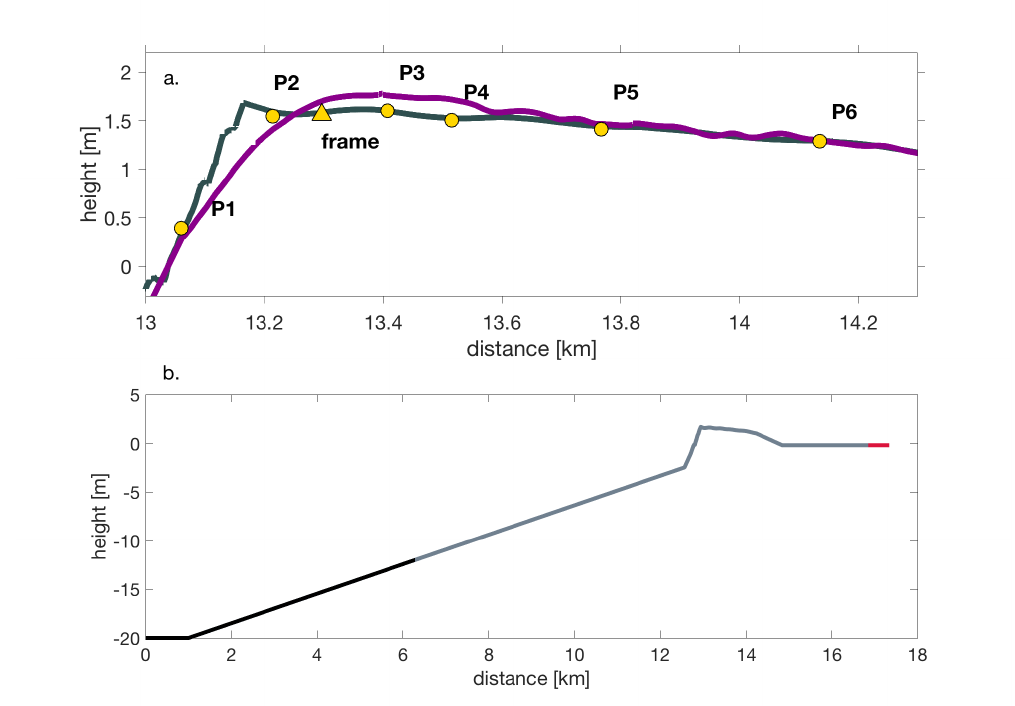
Figure 2. The initial (grey) and final (magenta) cross-shore profile for the observations ( a ). The yellow dots show the location of the pressure sensors and the triangle indicates the instrument frame. The profile for the model-data comparison ( b ). SWASH was first run to 12 m water depth (dark grey profile) and in a second run from 12 m depth to the back barrier basin (see text for more explanation). The red line indicates the sponge